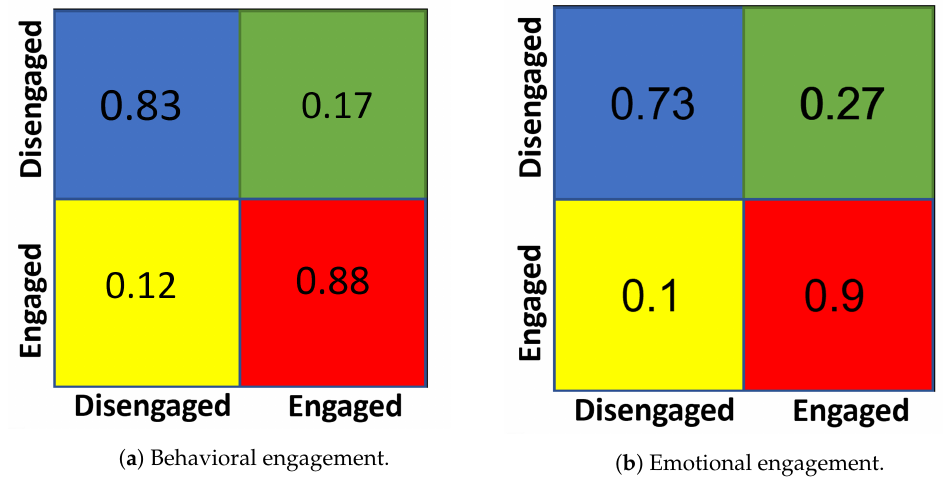
Figure 11. The confusion matrix of the proposed engagement